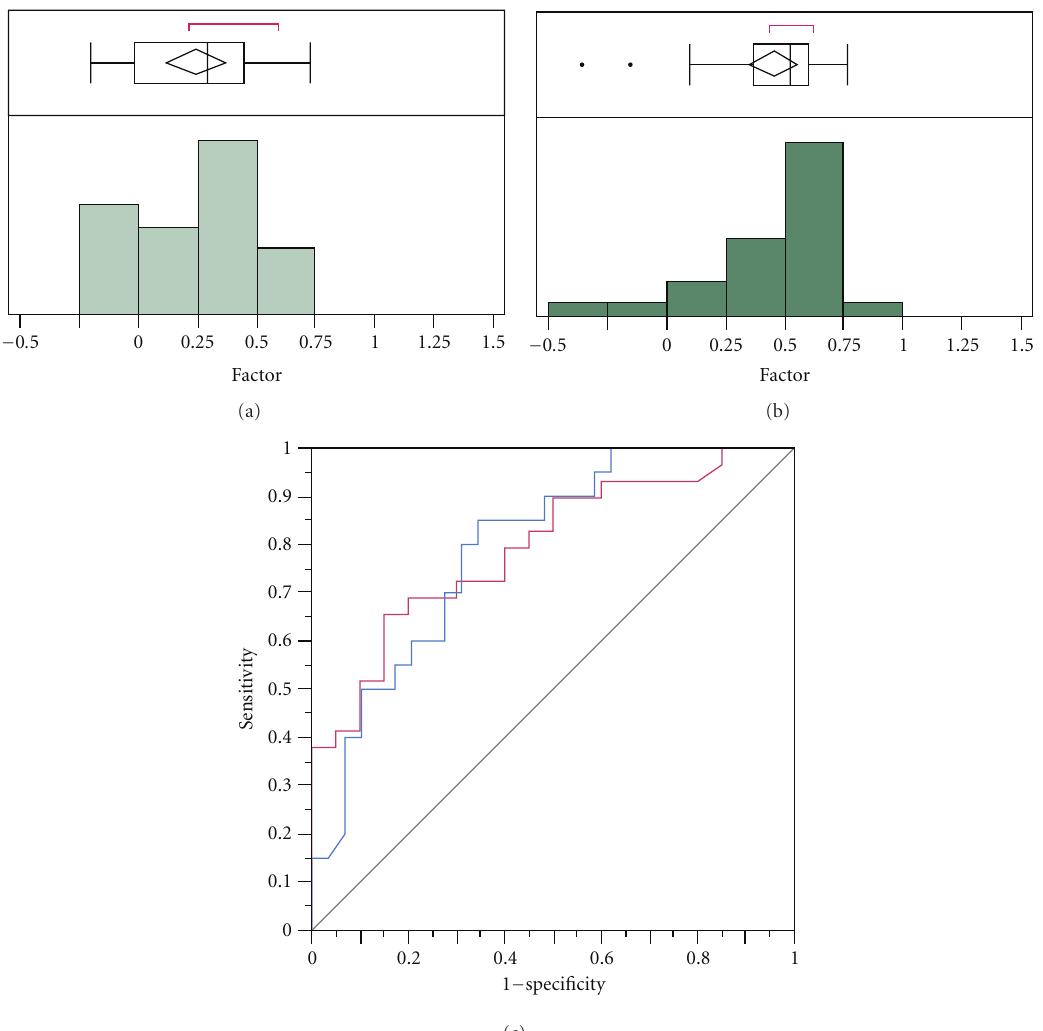
Figure 2: (a, b) Similar distributions of morphological factors for the MCI-S (a) and MCI-P groups (b). (c) ROC for the discrimination of MCI-S and MCI-P. The area under the ROC curve was 0.7940. At 72.3% accuracy, specificity was 62%, and sensitivity